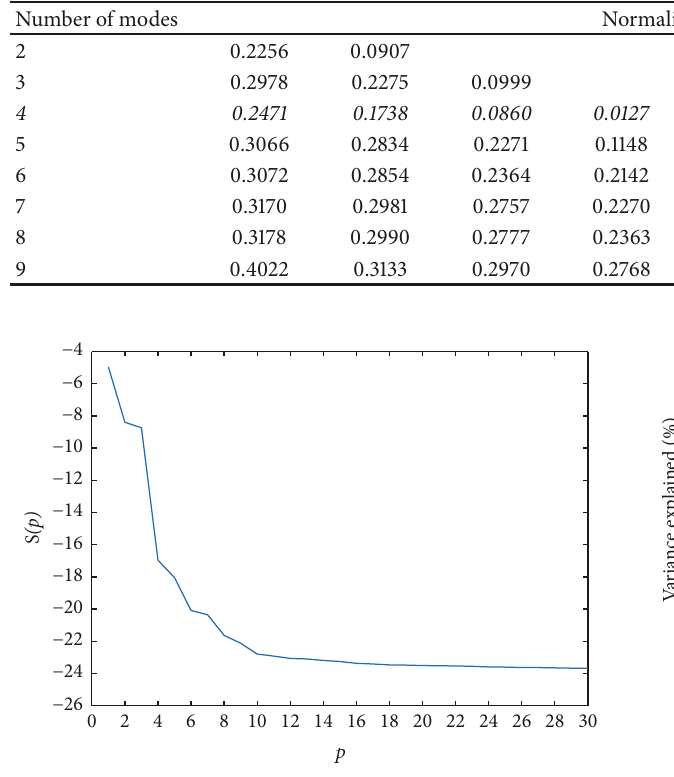
Figure 5: Selection of MAR model order p .